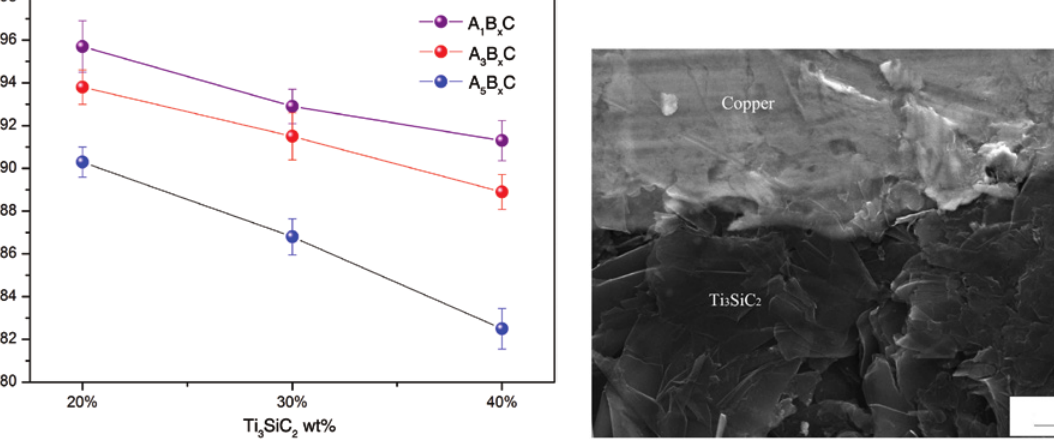
SiC /Al O HRCPs. 3 2 2 3